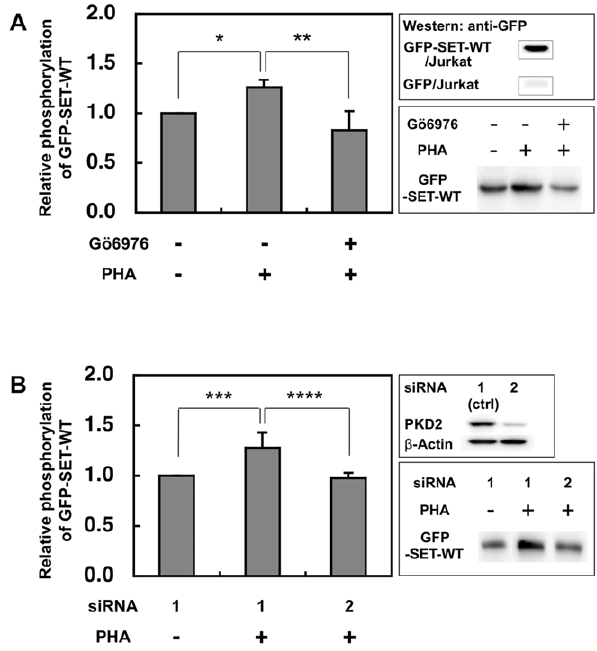
Figure 2. PKD2 is involved in the up-regulation of SET phoshorylation in activated Jurkat cells. (A) After Jurkat cells expressing GFP-SET were stimulated by PHA (2 m g/ml) with or without Go¨6976 (3 m M), the phosphorylated GFP-tagged SET was collected by PhosphoProtein Purification kit and separated by SDS-PAGE. The phosphoprotein was transferred onto the PVDF membrane and quantified by ECL using anti-GFP antibody and the secondary antibody. The typical blot was shown in the lower-right panel. The luminescence of samples from cells without both stimulation and the inhibitor was assigned to be 1. The results were expressed as mean + SD for three independent experiments. *, p , 0.01; **, p , 0.05. As shown in the upper-right panel, phosphorylated GFP was not detected from the eluate of the PHA stimulated Jurkat cells expressing GFP only. (B) Jurkat cells expressing GFP-SET treated with control (ctrl) siRNA1 had no effect on the PKD2 expression, while siRNA2 markedly reduced the PKD2 expression (upper-right panel). The typical blot was shown in the lower- right panel. The luminescence of the samples from non-stimulated and siRNA1-treated cells was assigned to be 1. The results were expressed as mean + SD for three independent experiments. ***, p , 0.05; ****, p , 0.05, as determined by Student’s t